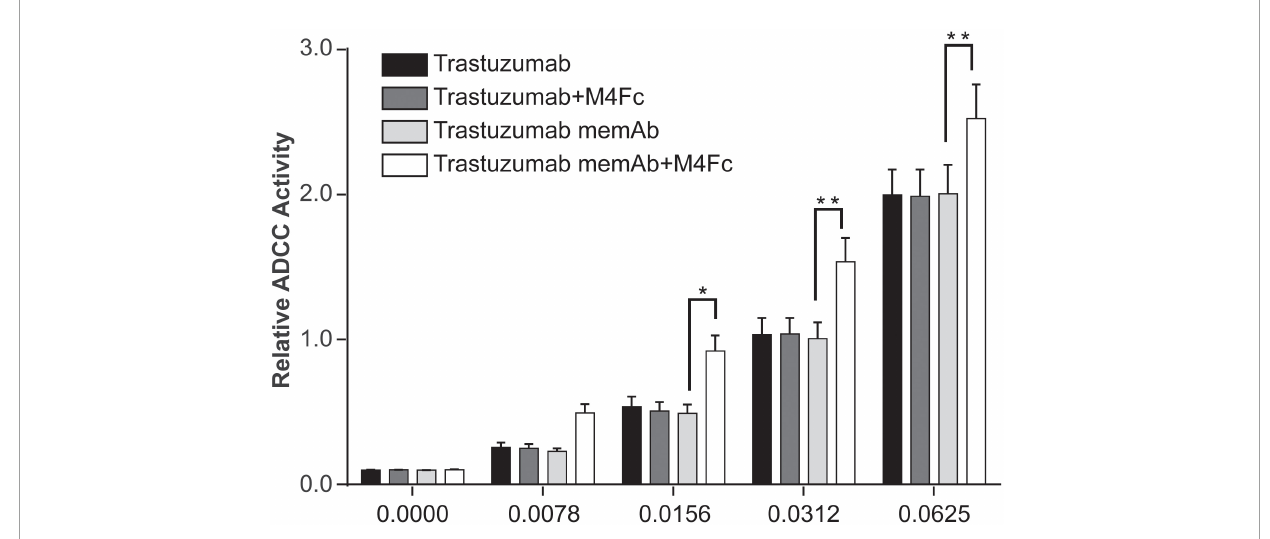
FIGURE5 Effects of M4Fc on ADCC in SK-BR-3 cells. ADCC activity was measured in SK-BR-3 cells treated with increasing doses of trastuzumab or trastuzumab memAb in the presence or absence of 10 nM M4Fc for 6 h. Data was compiled from three experiments and analyzed using a 2-way ANOVA (* p < 0.05; ** p < 0.01). Data is normalized to the untreated (0 nM antibody) cell signal. Treatment with M4Fc in the presence of trastuzumab memAb shows higher levels of ADCC